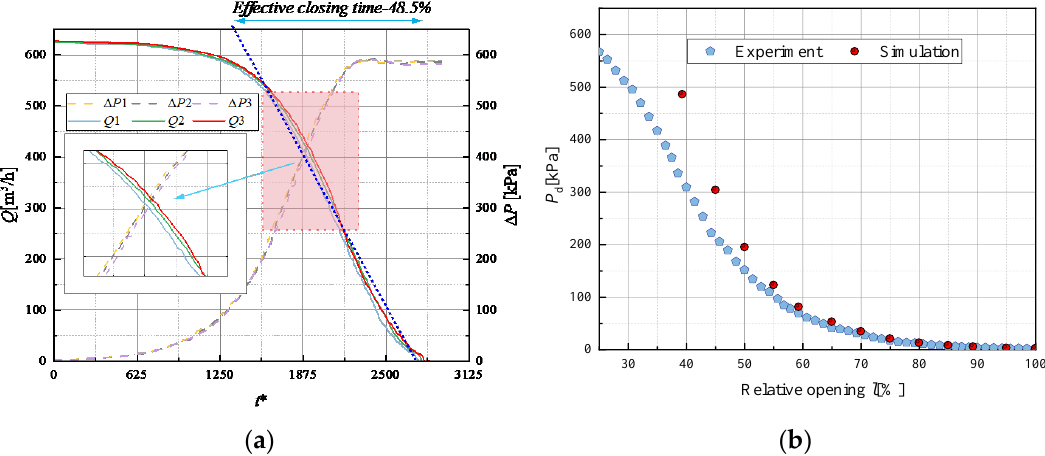
Figure 6. Experimental results and numerical simulation verification: ( a ) Time course curves of flow and differential pressure inlet and outlet. ( b ) Change curve of the inlet and outlet pressure difference with the relative opening.